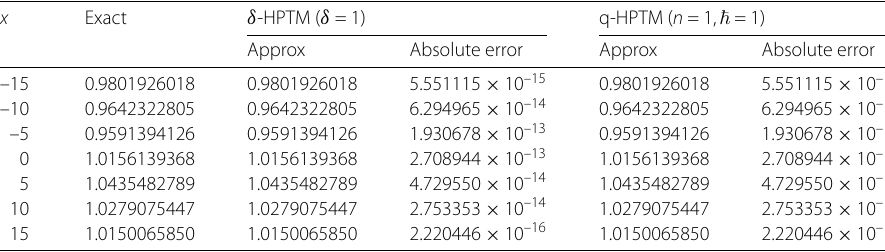
Table 3 The comparative study of Re[ W (3) ] solutions of δ -HPTM, q-HATM, and exact solution for Example 2 at β 1 = 1, β 2 = 2, β 3 = 0.1, y = 2, z = 2, ξ = 0.1, e 0 = 1, p = 0.8, q = 0.8, φ = 1, and t = 0.01